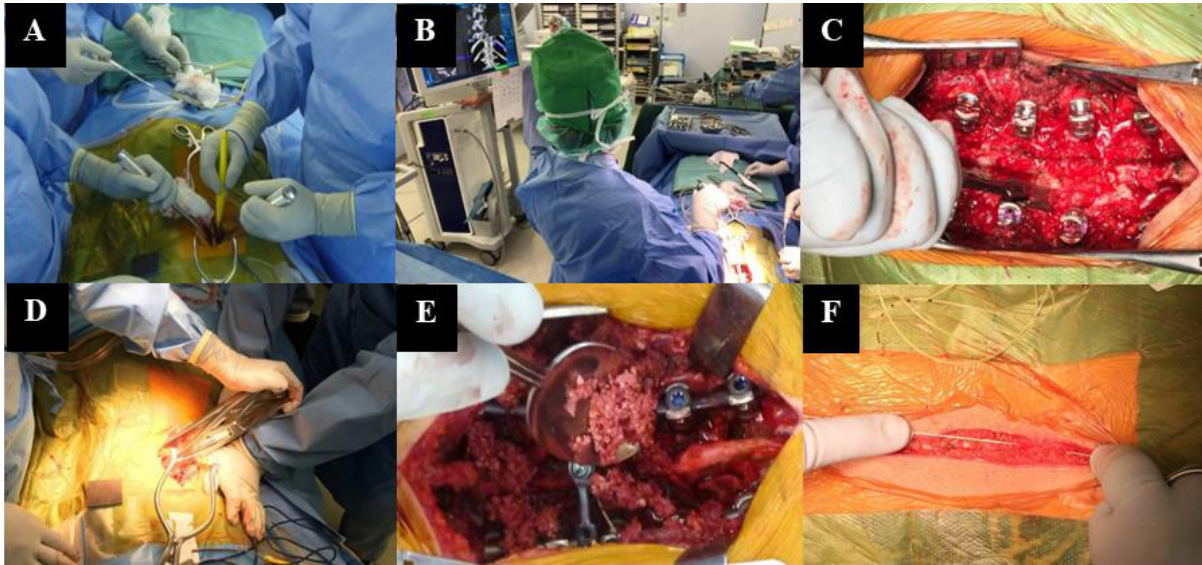
Figure 2. Six stages of PSF. ( A ) Exposure (stage 1), ( B ) Implant placement (stage 2), ( C ) Release (stage 3), ( D ) Correction (stage 4), ( E ) Bone grafting (stage 5), ( F ) Closure (stage 6).